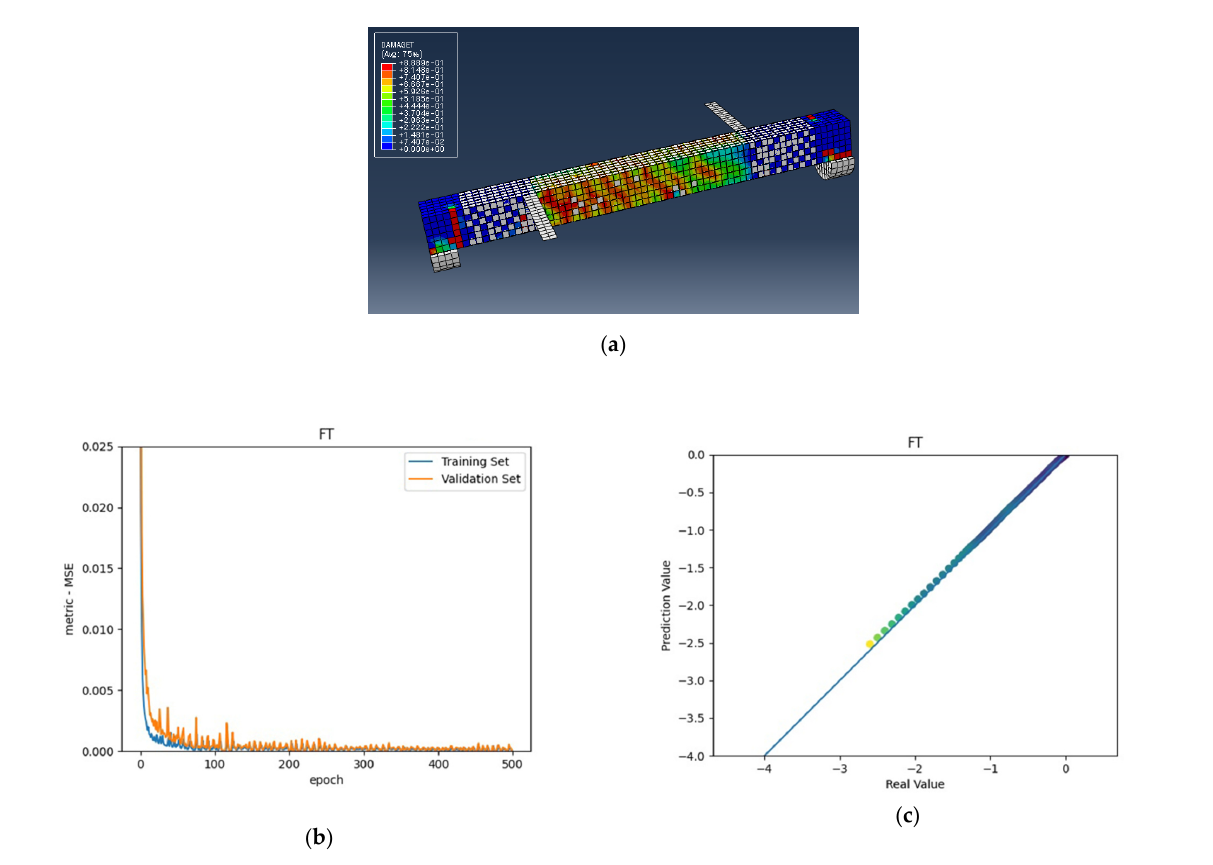
Figure 6. ( a ) FT beam under combined torsion and bending, ( b ) Training loss, ( c ) Accuracy.